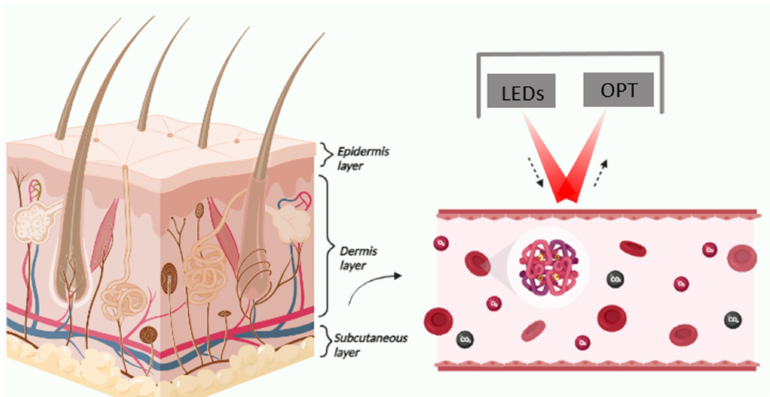
Figure 16. Skin tissue and light absorption of erythrocytes. In this figure, the device mechanism is in reflective mode. This figure was created with BioRender.com (accessed on 26 May 2021).